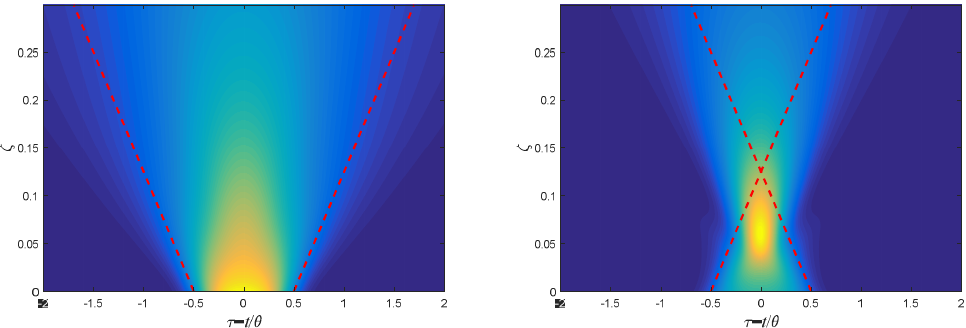
Figure 19. Same as Figure 8 but for a smooth rectangular pulse with ∆ = 0.25 θ